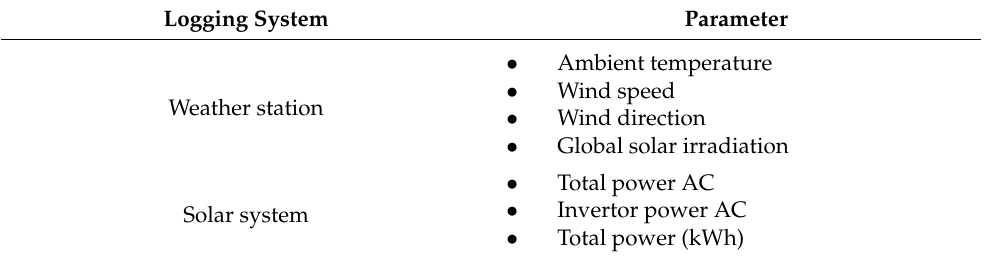
Table 4. The list of the measured